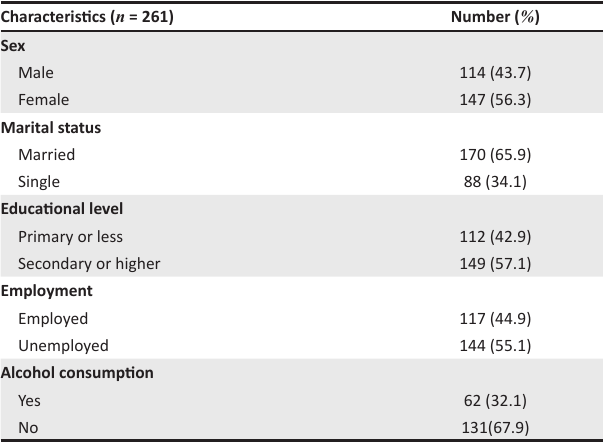
TABLE 1: Baseline demographics for diabetes-related characteristics in a sample population.